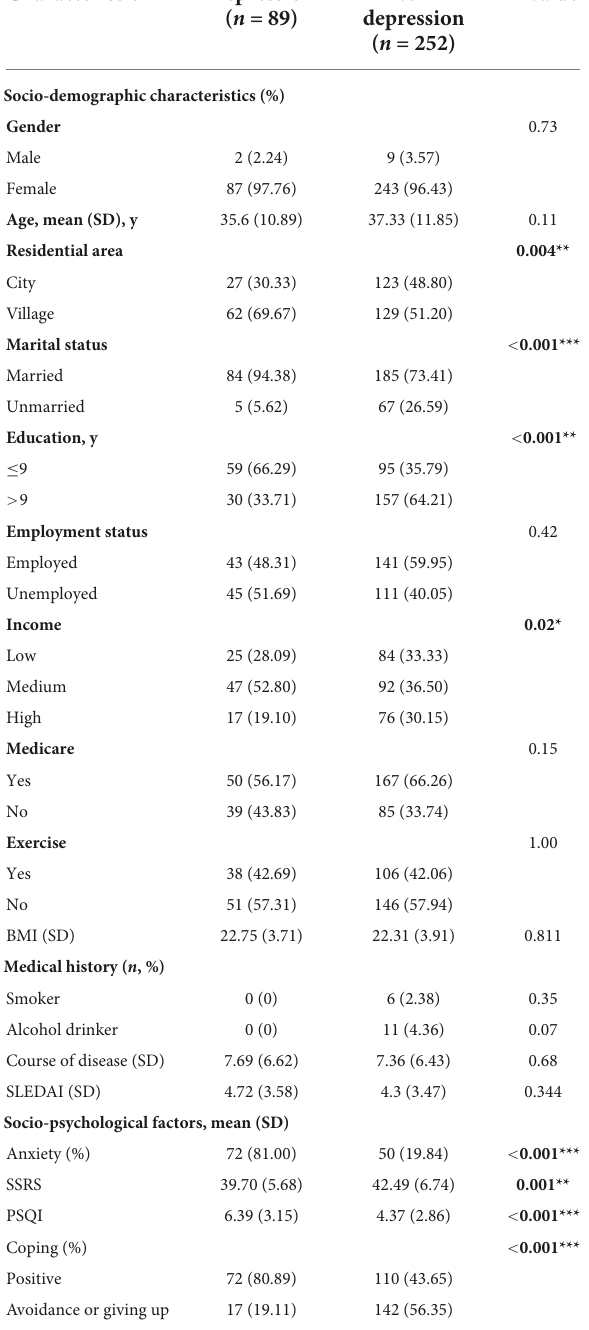
TABLE 1 Baseline characteristics of patients with and without depression.